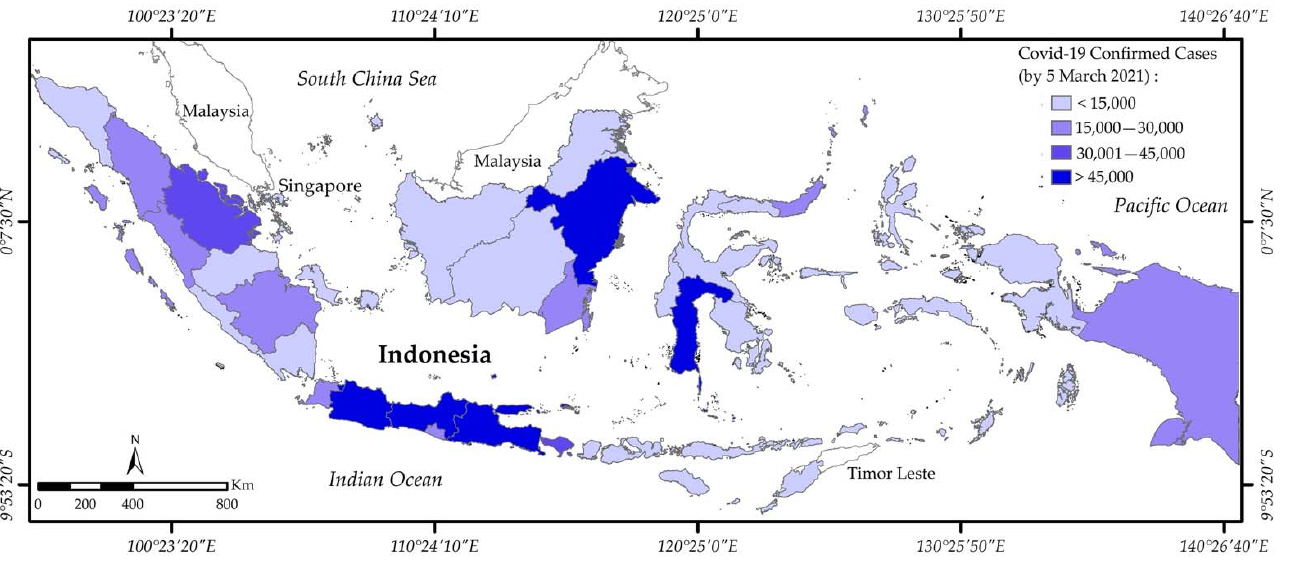
Figure 2. Indonesia’s confirmed COVID-19 cases by province (Image source: author). Like all nations worldwide, Indonesia has faced the widespread repercussions of COVID-19 not only in its public health but also in its economy. The COVID-19 pandemic has slowed the economic growth in Indonesia, as observed from the country’s Gross Domestic Product (GDP) growth contracting in the first and second quarters of 2020 [10,46].